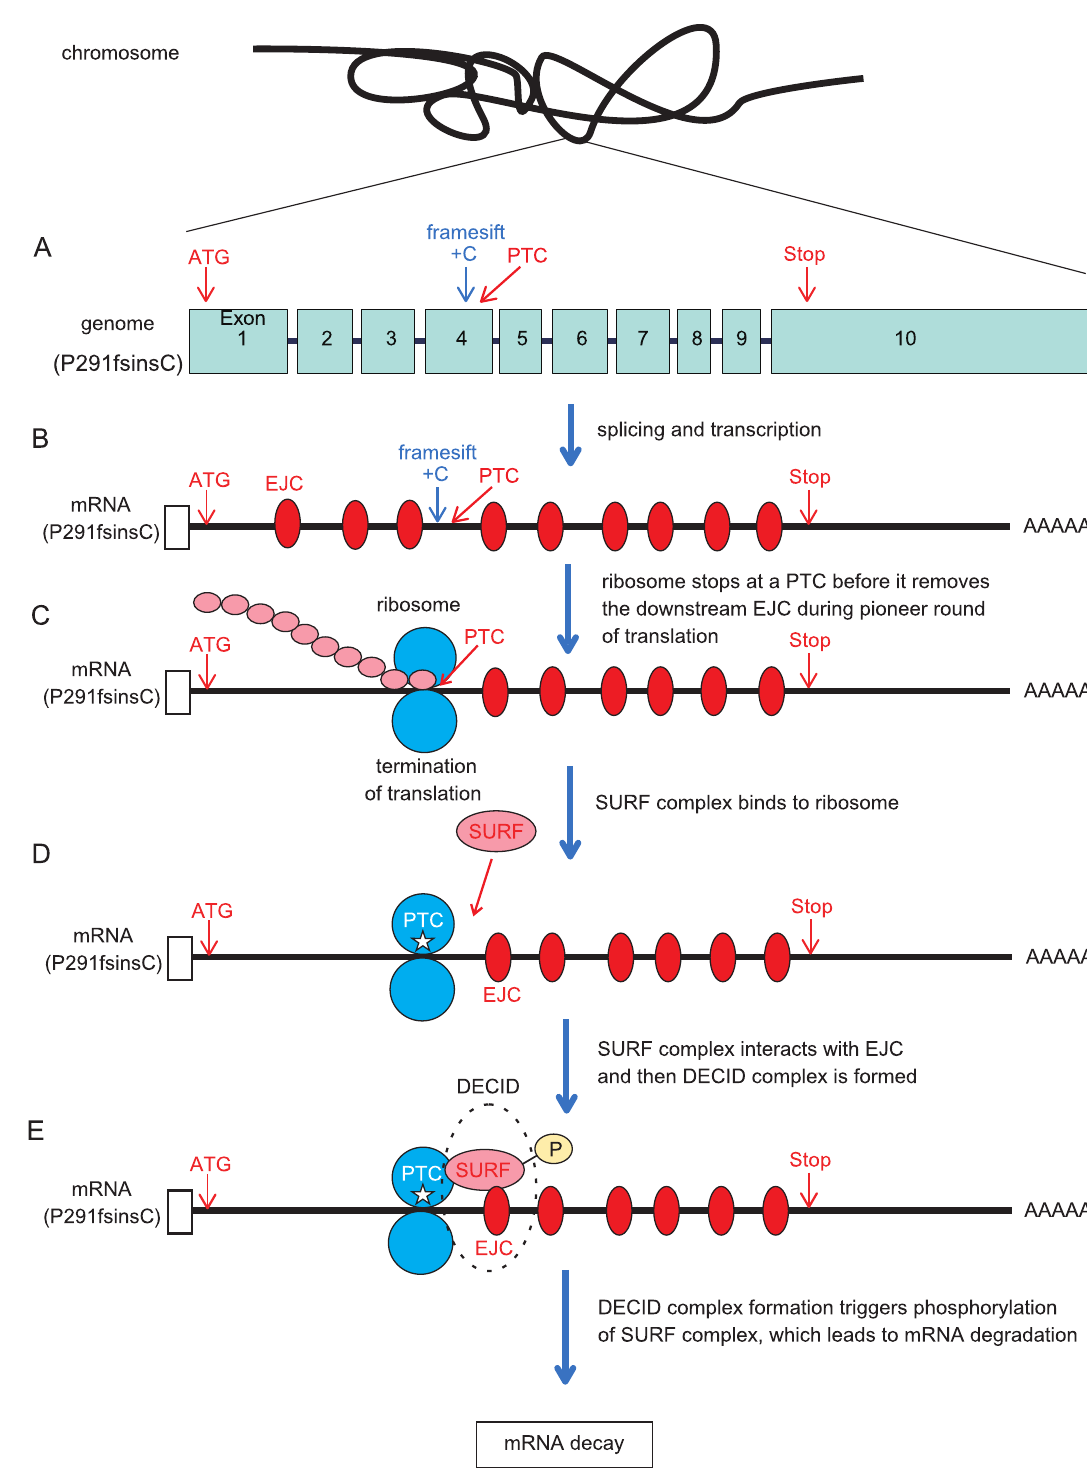
Fig 6. Putative schema of NMD for P291fisnsC mutant mRNA in MODY3-derived beta cells. (A) HNF1A genomic DNA has 10 exons and 9 introns. PTC exists within exon 4, and the original stop codon is located within exon 10. (B) After P291fsisnC mRNA is transcribed from genomic DNA and spliced, 9 exon junction complexes (EJC) are left. (C) During pioneer round of translation of P291fsinsC mutant protein, ribosome stops at a PTC, leaving the downstream EJC. (D) When translation is finished, SURF complex binds to ribosomes. SURF complex interacts with EJC and then DECID complex is formed. (E) DECID complex formation triggers